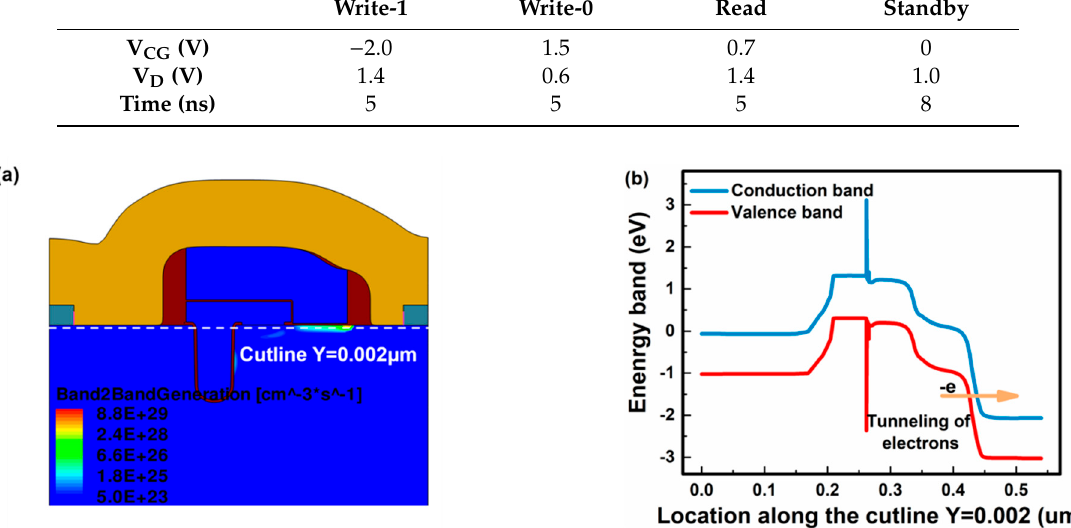
Table 1. The operation condition of the U-shaped (semi-floating gate transistor) SFGT memory. Write-1 Write-0 Read Standby